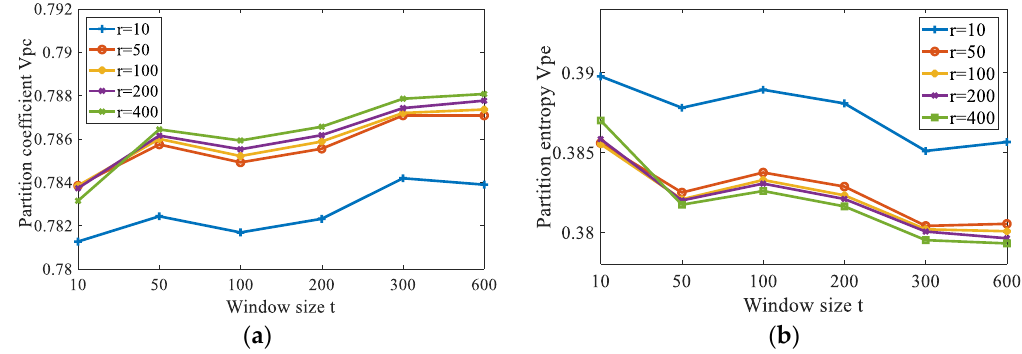
Figure 8. The partition coefficient v pc , and partition entropy v pe of FCM_NNS with different size of non-neighborhood information. ( a ) The partition coefficient v pc , ( b ) The partition entropy v pe .